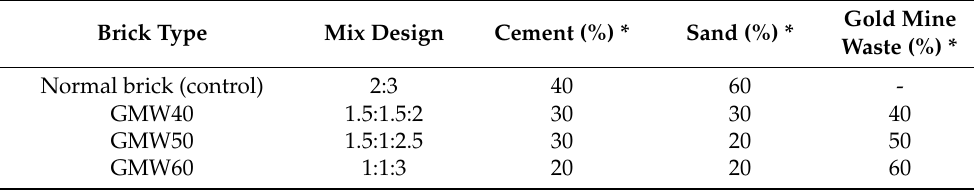
Table 2. Mixture proportion of gold mine waste bricks.